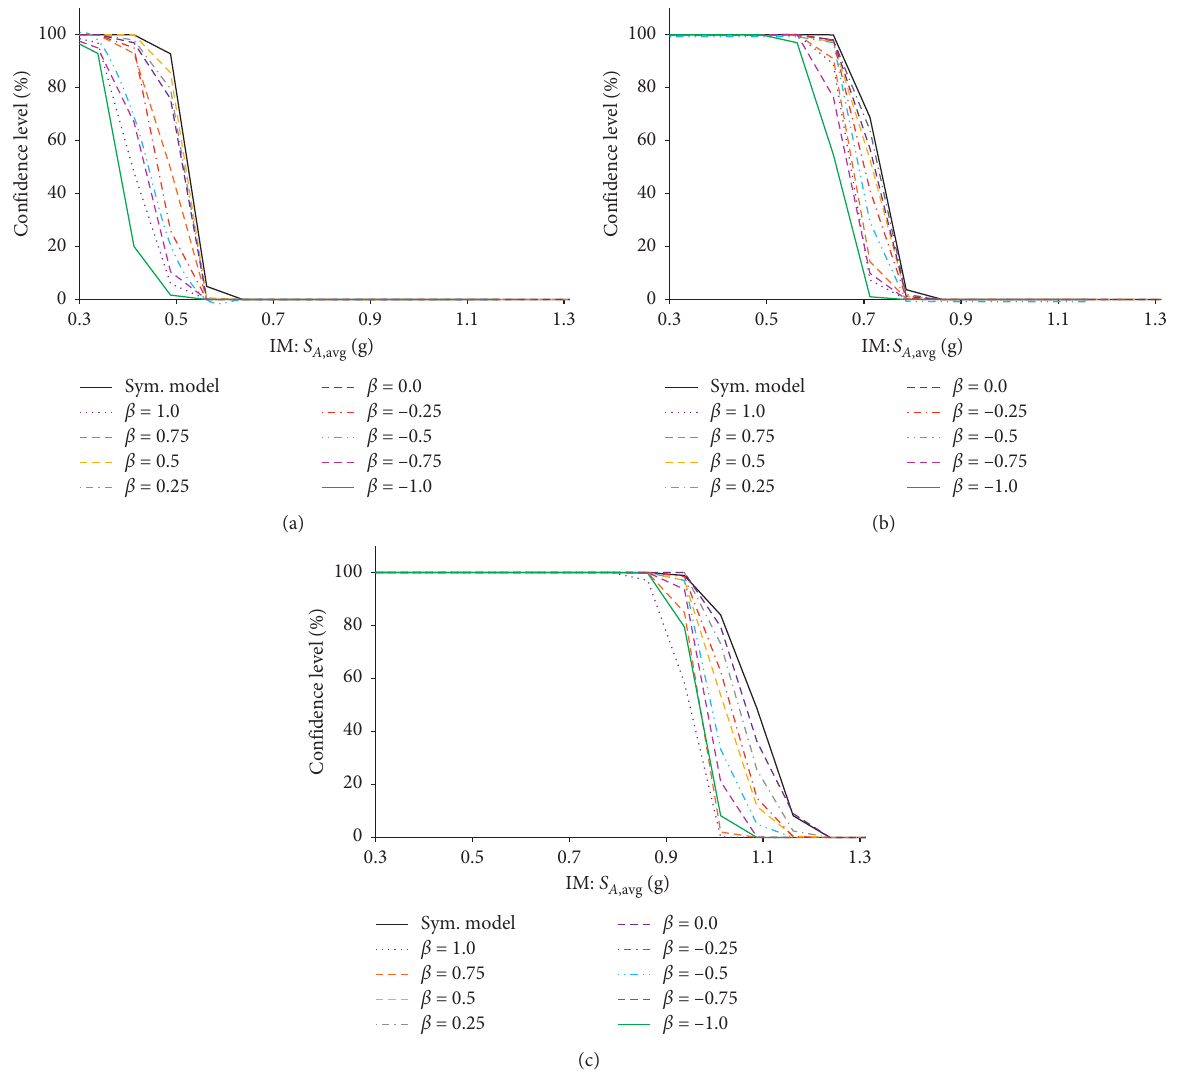
Figure 17: Confidence levels for models with fixed base: (a) IO, (b) LS, and (c)